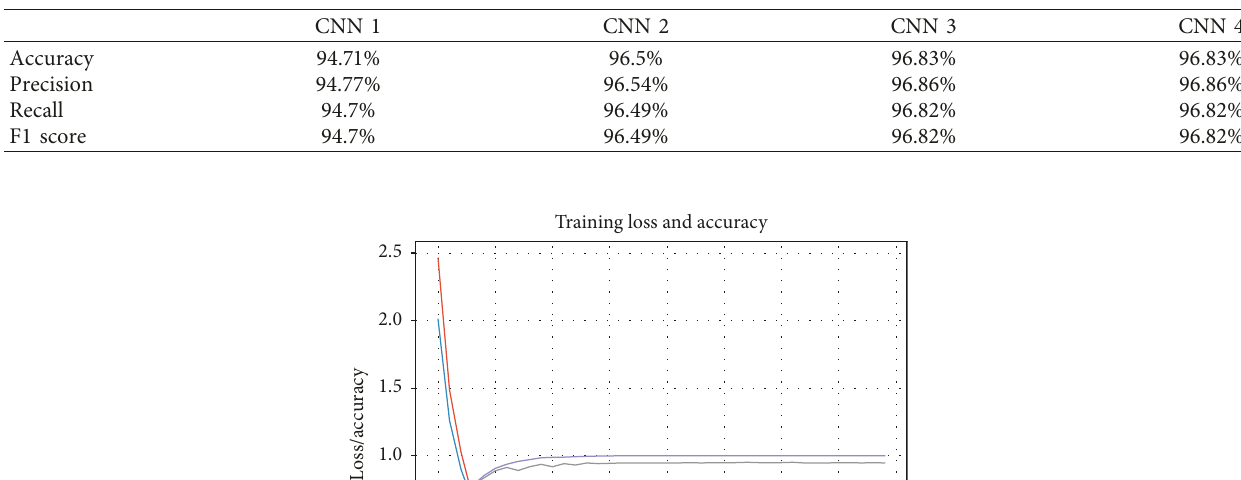
Table 2: Results obtained with the proposed architectures.